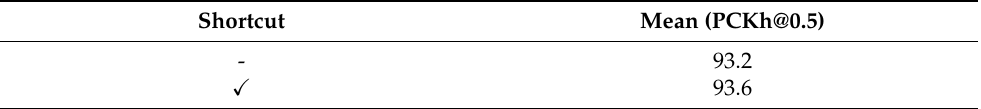
Table 5. Ablation experiment of the